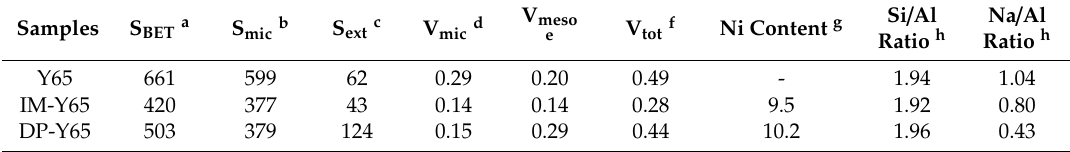
Figure 1. XRD di ff ractograms of ( a ) Y65, ( b ) IM-Y65, and ( c ) DP-Y65. The symbol indicates the characteristic di ff raction peak for nickel oxide. Table 1. Chemical composition and physical properties of Y65 and NiO-modified Y65.